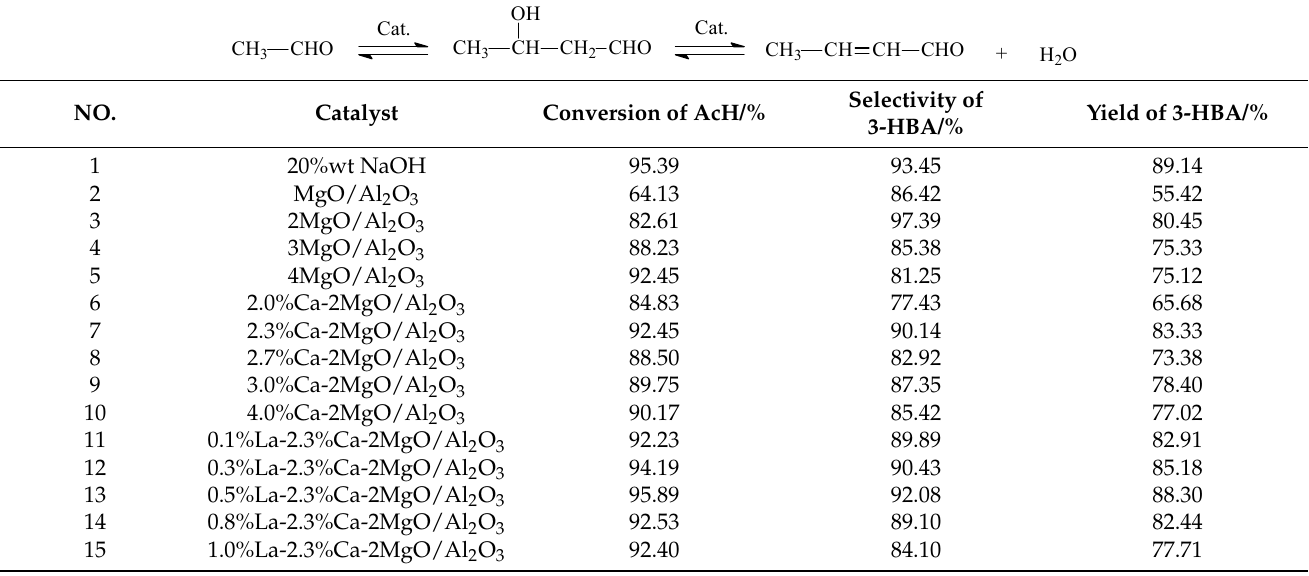
Table 1. Catalytic performance evaluation of composite oxides on AcH condensation.